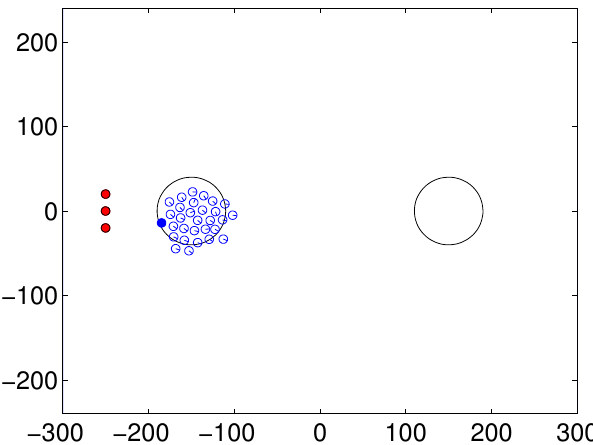
Figure 1. Snapshot of multi-robots for shepherding at the initial state (red-colored robots: steering robots); the left circle indicates the starting point and the right circle the destination